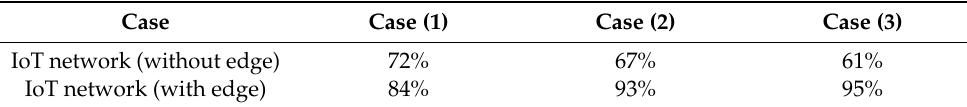
Table 10. Percentage of average remaining energy of IoT networks, after task execution, in case (II) of the second